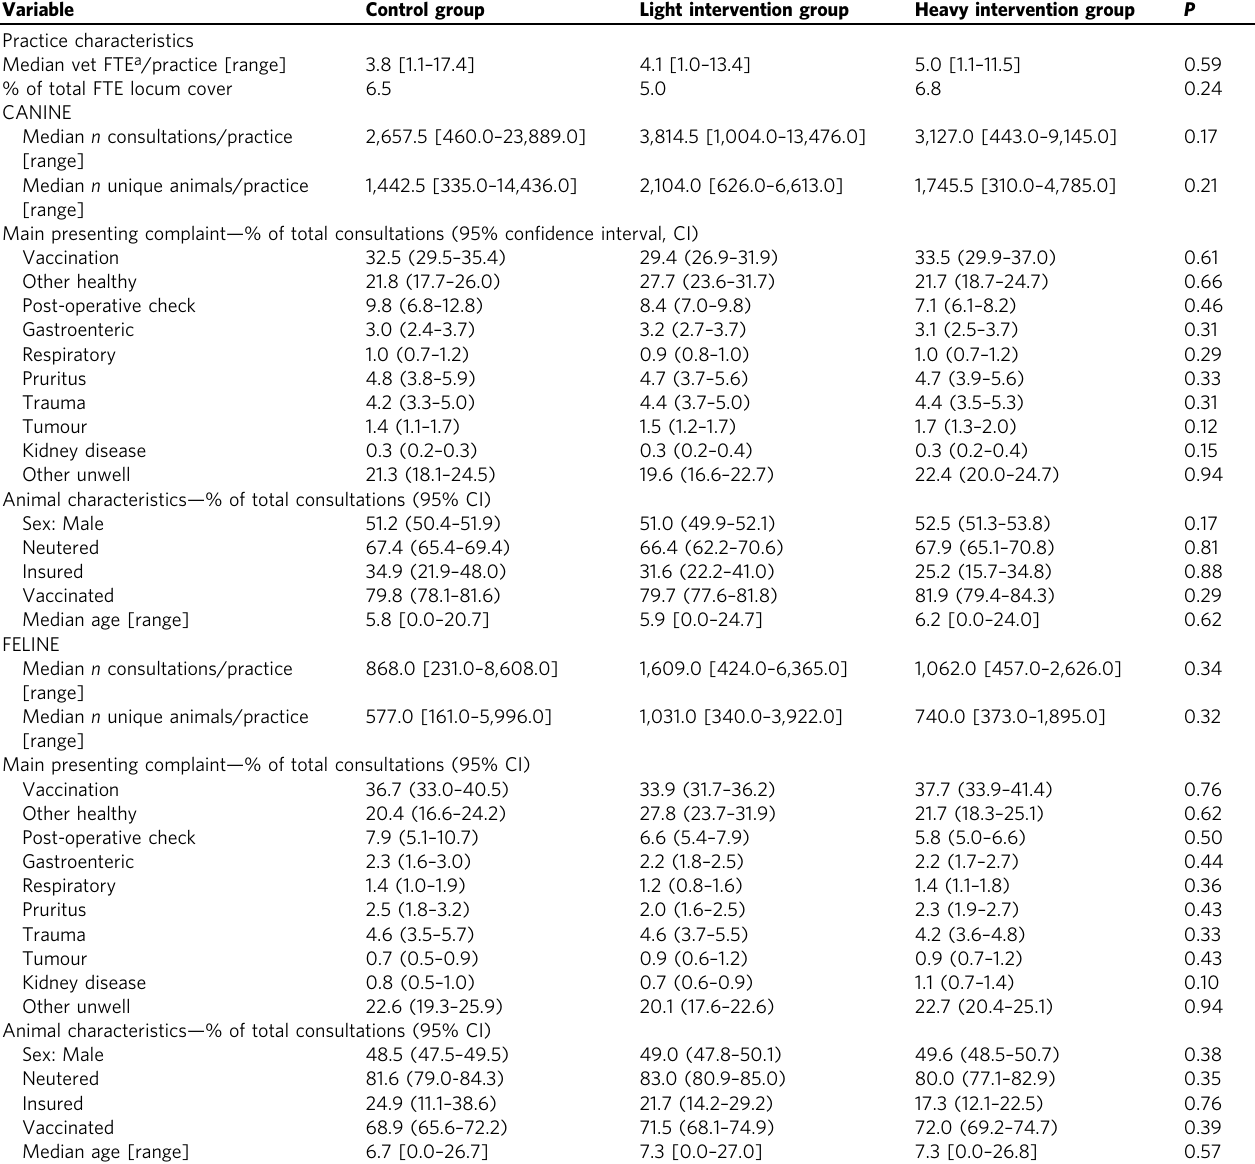
Table 1 Practice, canine and feline pre-intervention (August 2018 – March 2019 inclusive) baseline